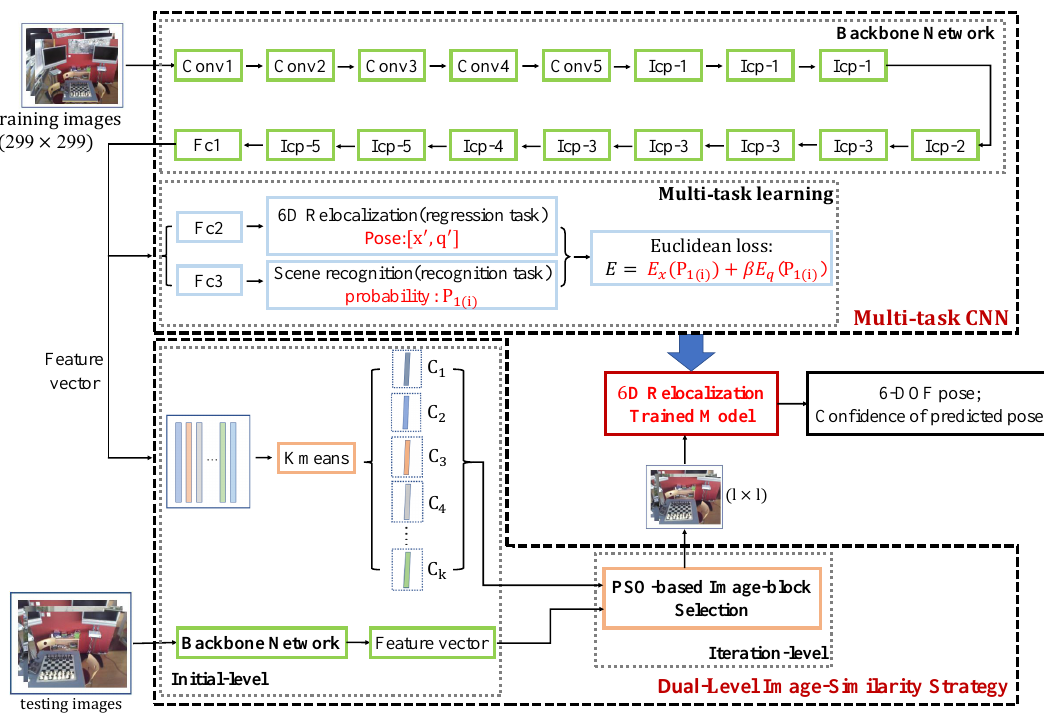
Figure 2. Overview of the proposed relocalization method (taking Chess dataset of 7Scenes as an example). Firstly, for training images, we process the images by center cropping, and then scale them to the size 299 × 299. In training section, we use GoogLeNet Inception V3 as a 6D relocalization